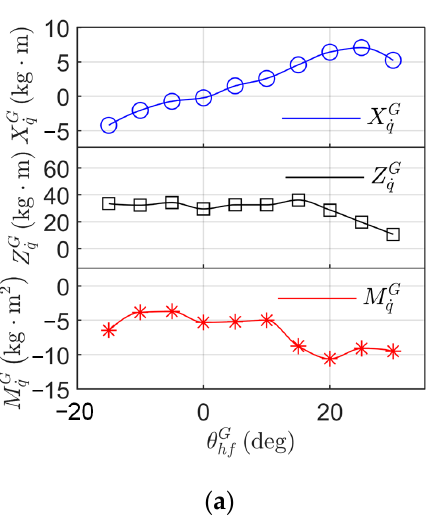
. q dependent added mass coefficients;